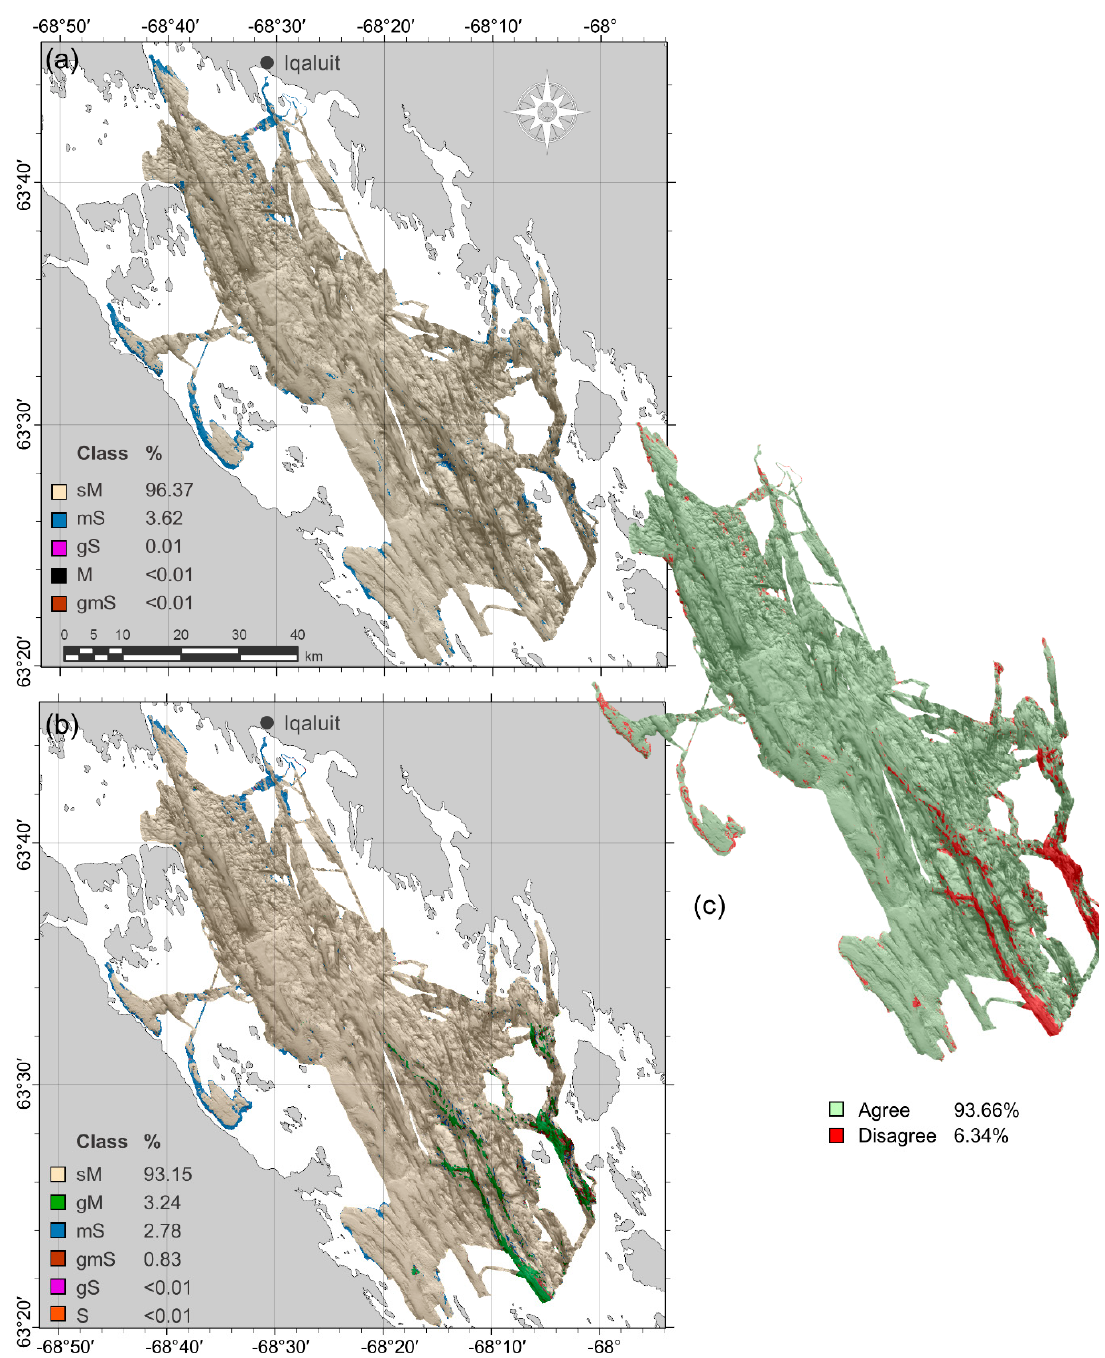
Figure 9. Predicted simplified Folk grain size classes for ( a ) categorical and ( b ) quantitative models, with ( c ) agreement between predictions.